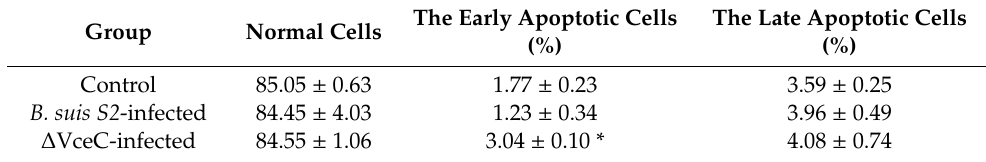
Table 1. Results of Annexin V-FITC / PI staining for cell apoptosis after B. suis S2 and ∆ VceC infection at 12 h.